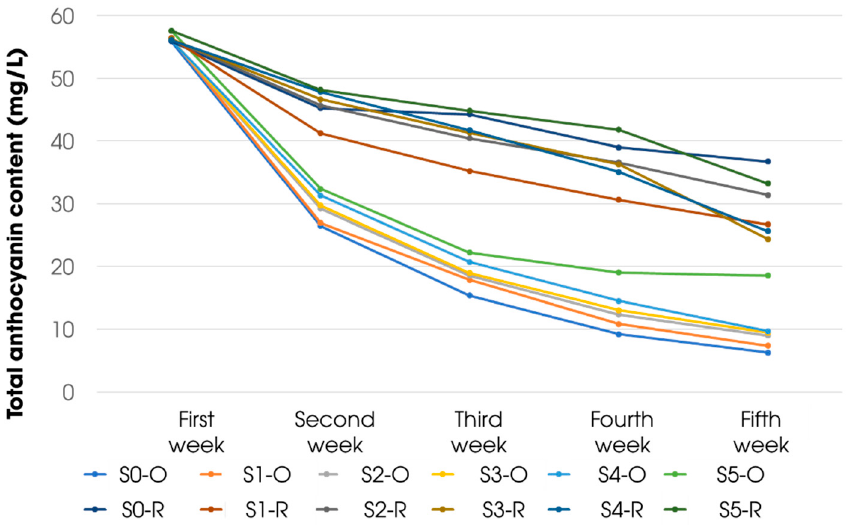
Figure 10. Anthocyanin content of aqueous solutions of extracts over time of color at room temperature and at 45 °C.